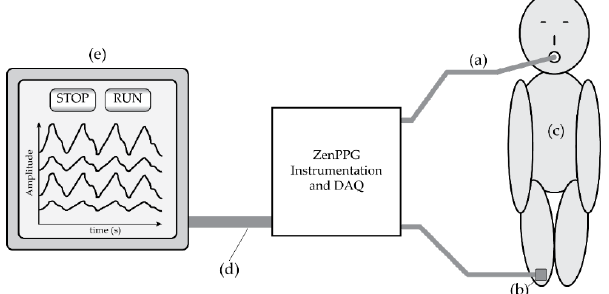
Figure 2. A system diagram of the tracheal PPG monitoring set-up. ( a ) The cable connecting to the ET sensor. ( b ) The reference peripheral PPG sensor and cable, which was placed on either the finger or toe of the patient, depending on where the commercial sensor was placed. ( c ) The patient. ( d ) The cable connecting the Zen instrumentation and data acquisition device to the laptop computer. ( e ) The laptop computer containing the data-logging and signal visualisation software.